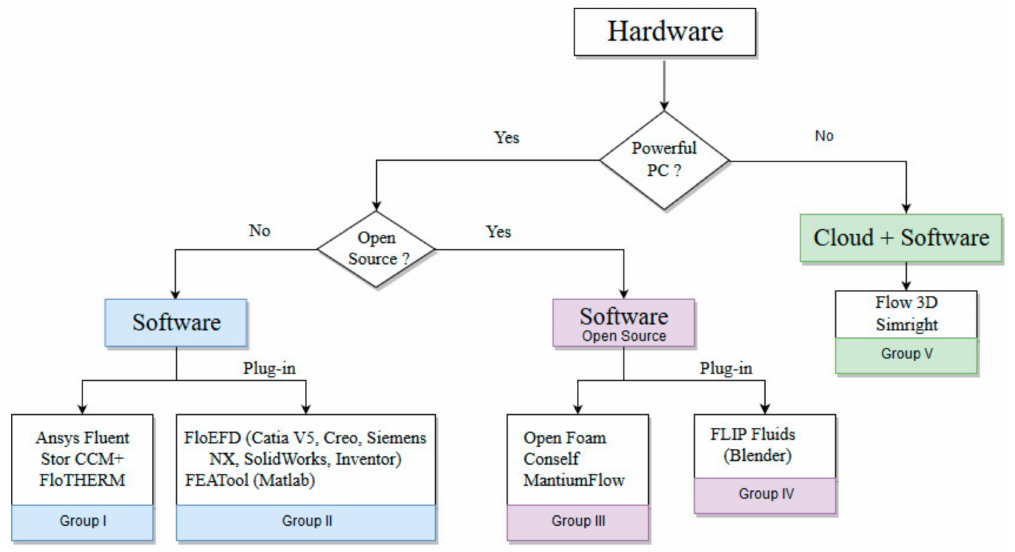
Figure 6. Software decision